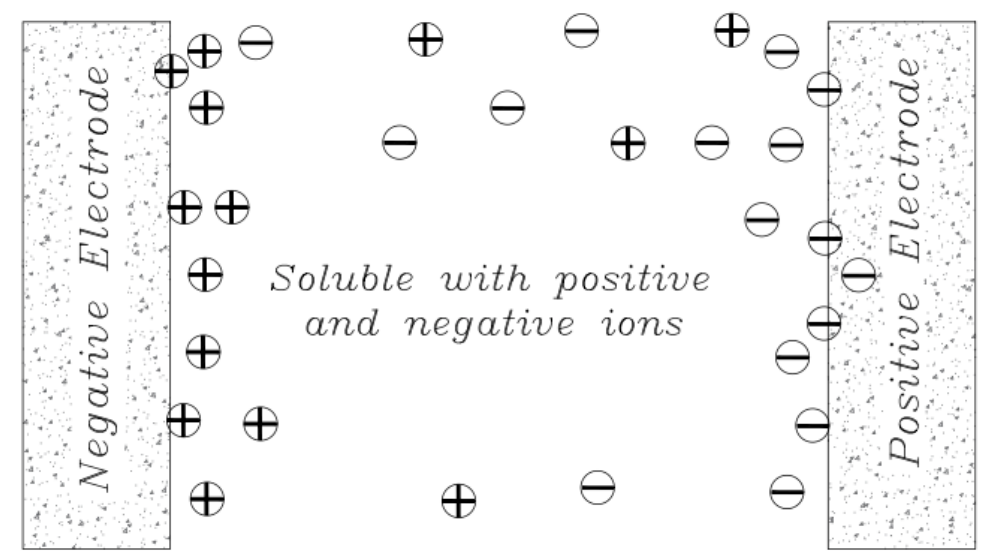
Figure 12. Schematic of ion transfer and principles of Electrical Double Layers formation and charge distribution in a system consisting of two electrodes.